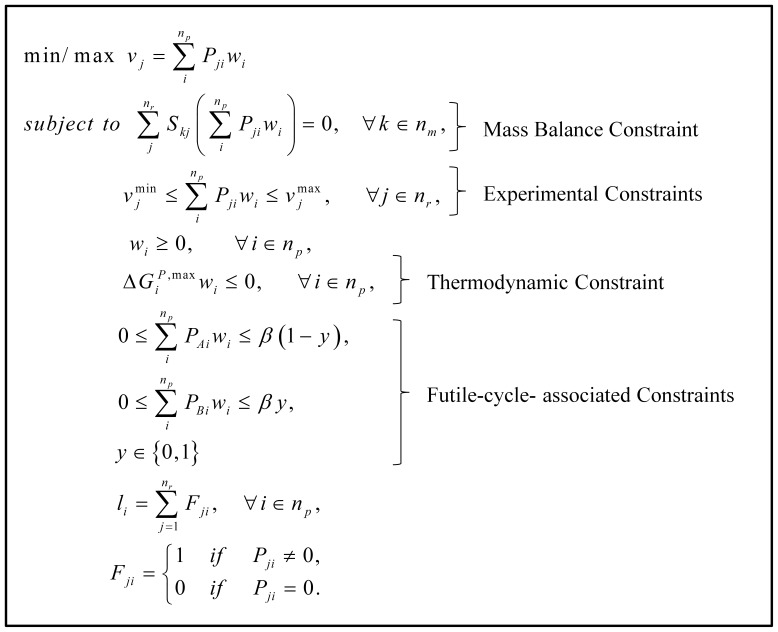
Mathematical model utilized to calculate the flux ranges.See text for detailed explanations.